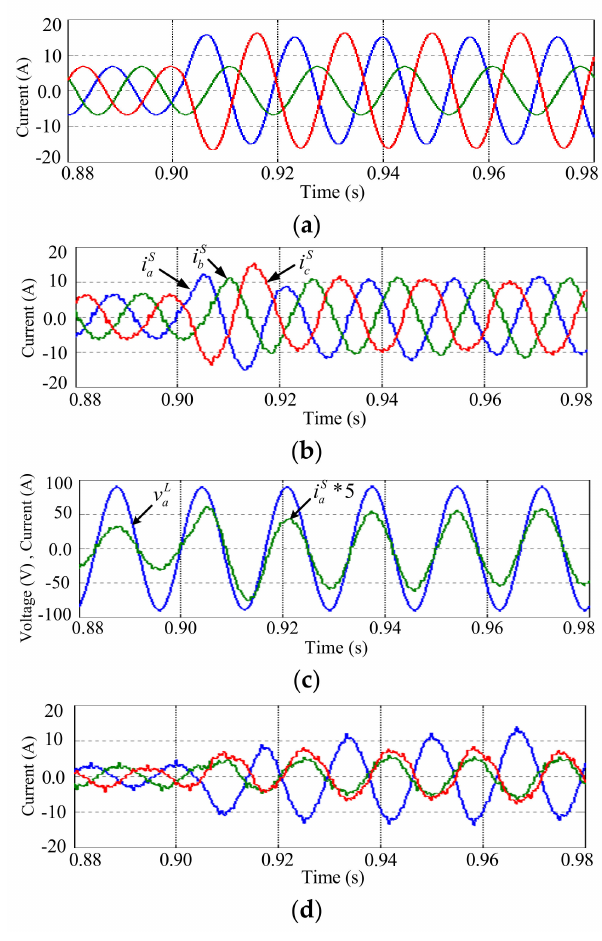
Figure 6. Compensation effect of STATCOM ( a ) Load current ( i L